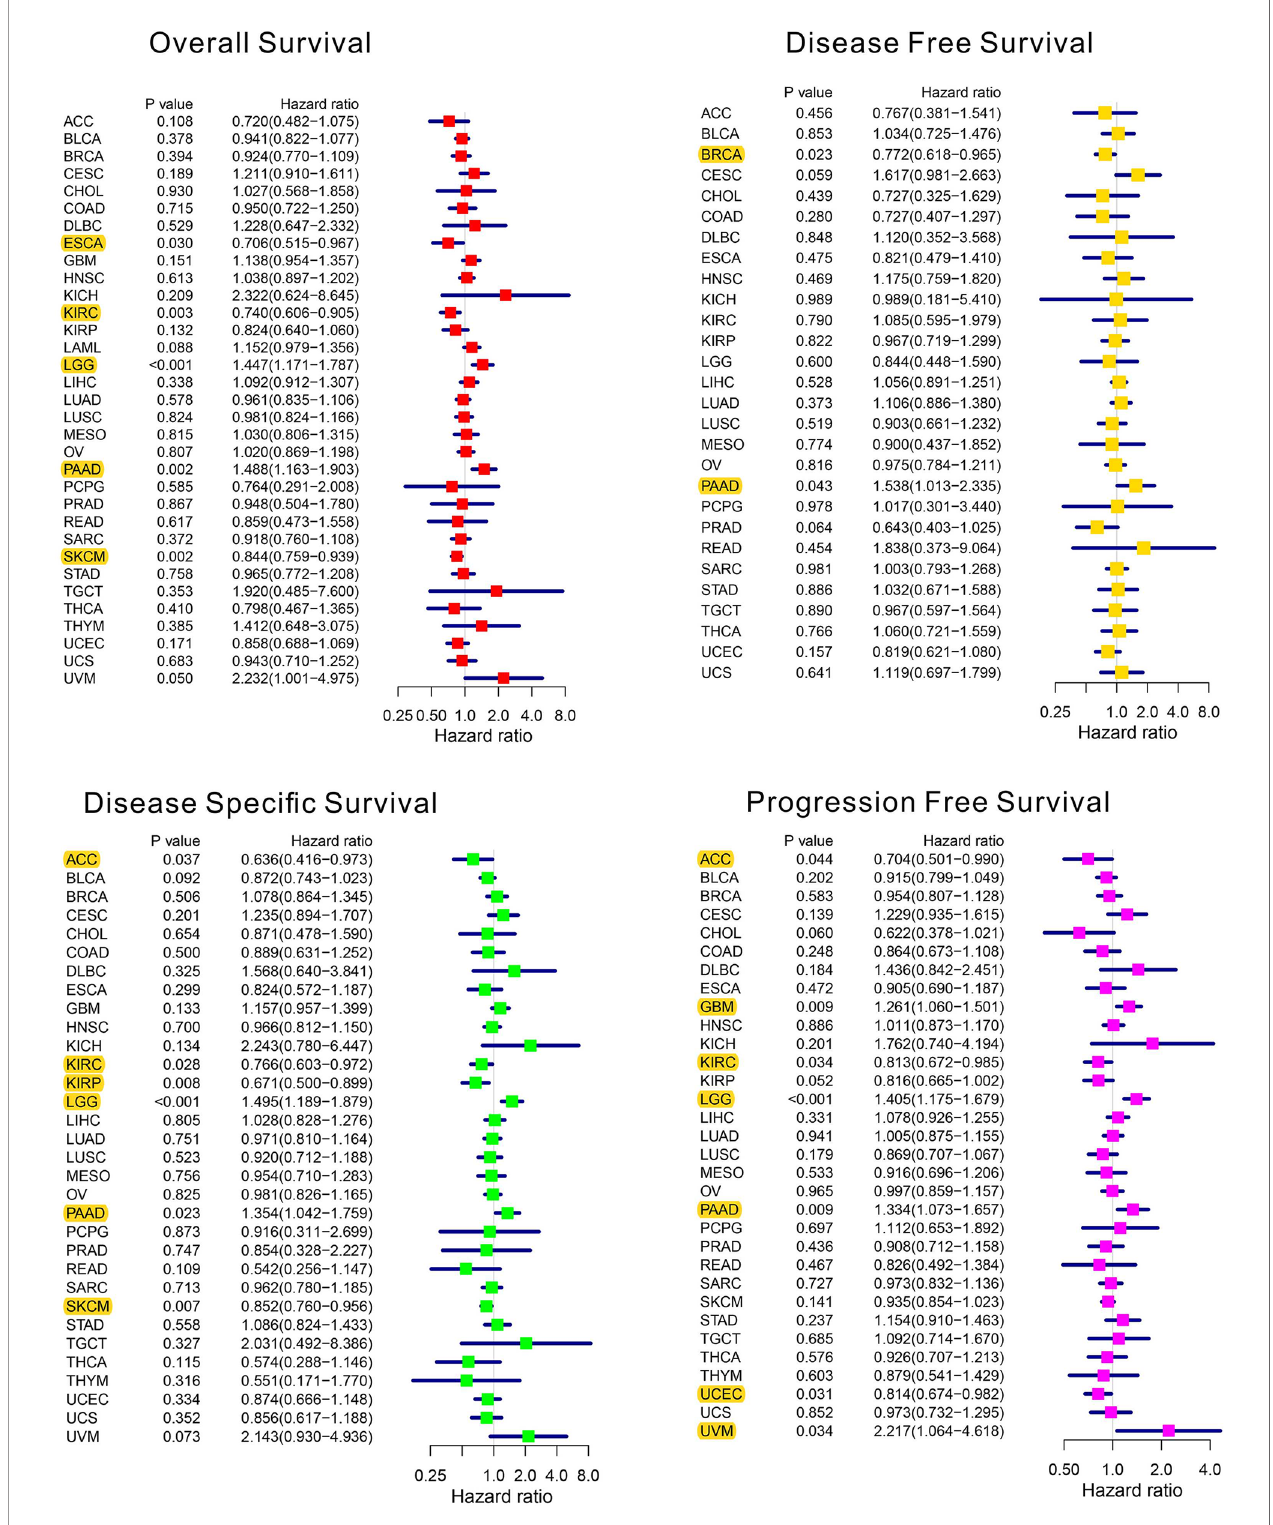
FIGURE 4 | The forest plots of univariate Cox regression analyses. The highlight items mean that AhR expression was signi fi cantly correlated with prognosis in these types of cancers ( p < 0.05). Items with hazard ratio greater than 1 indicated that the AhR expression was a promoting factor of death.